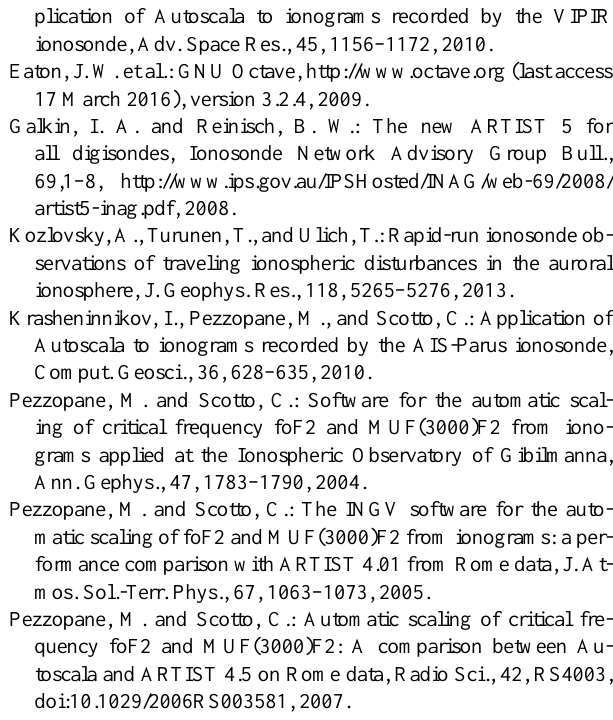
black lines show manually scaled parameters, and red colour (lines and/or letters) indicates Autoscala